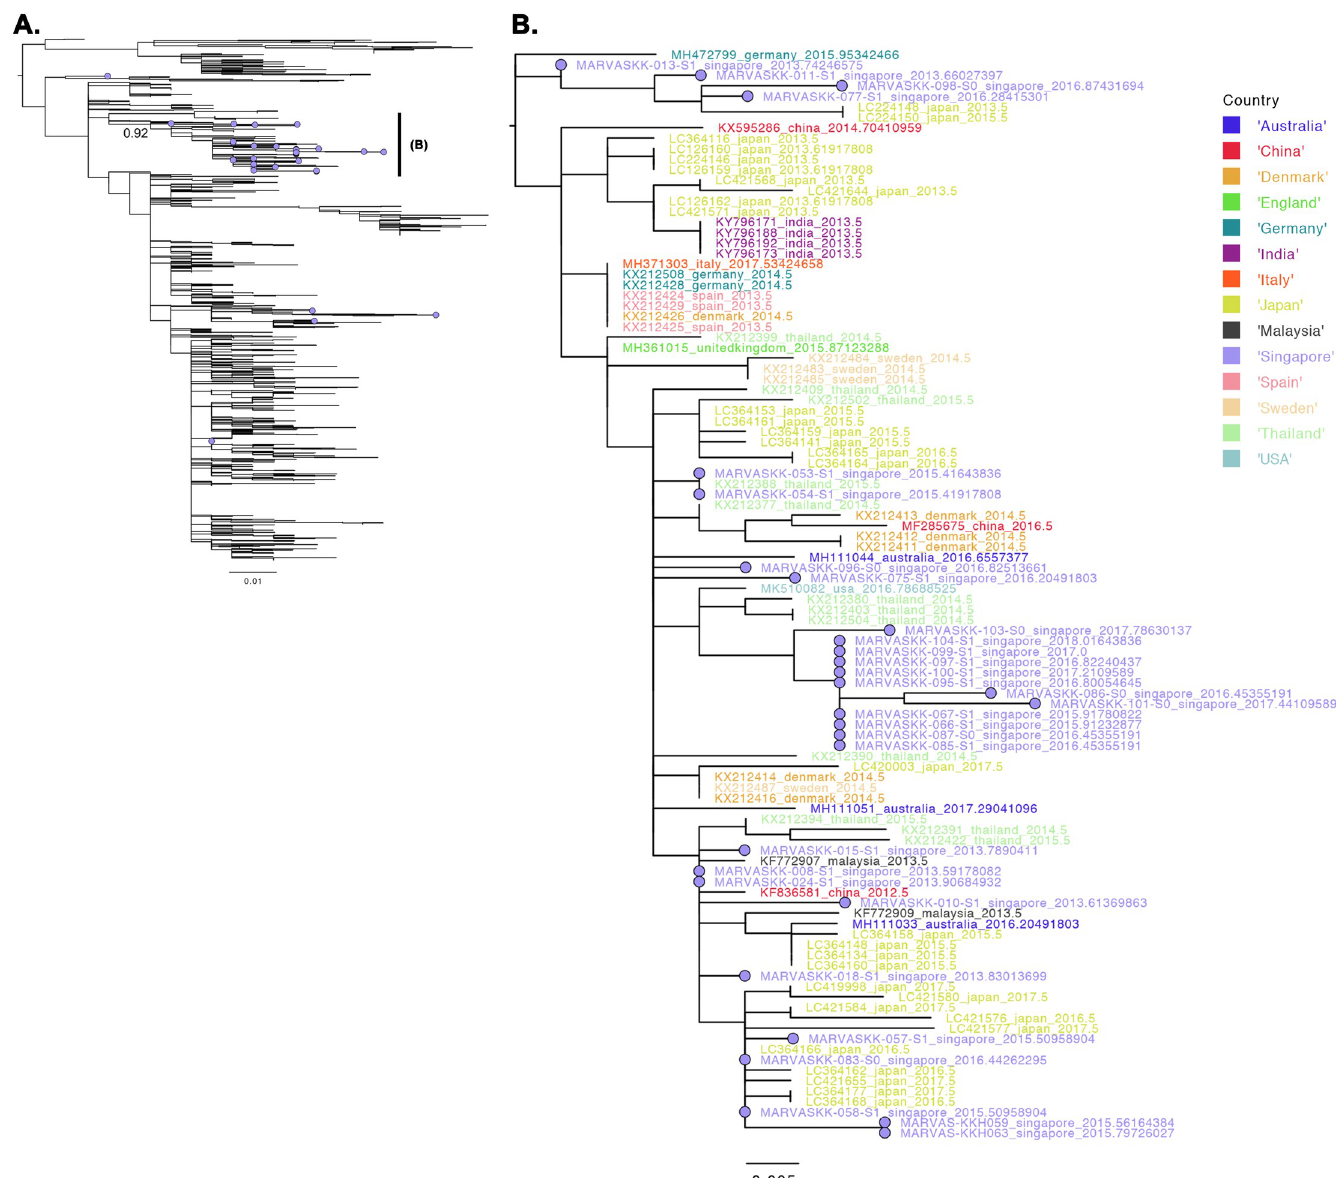
Fig 3. Maximum likelihood tree of CV-A6 viruses. (A) Phylogenetic tree of GenBank reference and Singaporean sequences. Singapore sequences are annotated with violet coloured tips and are largely found in the two labelled monophyletic clades of sequences with well-supported internal nodes (bootstrap support = 92%). (B) Zoom of the labelled subtrees in